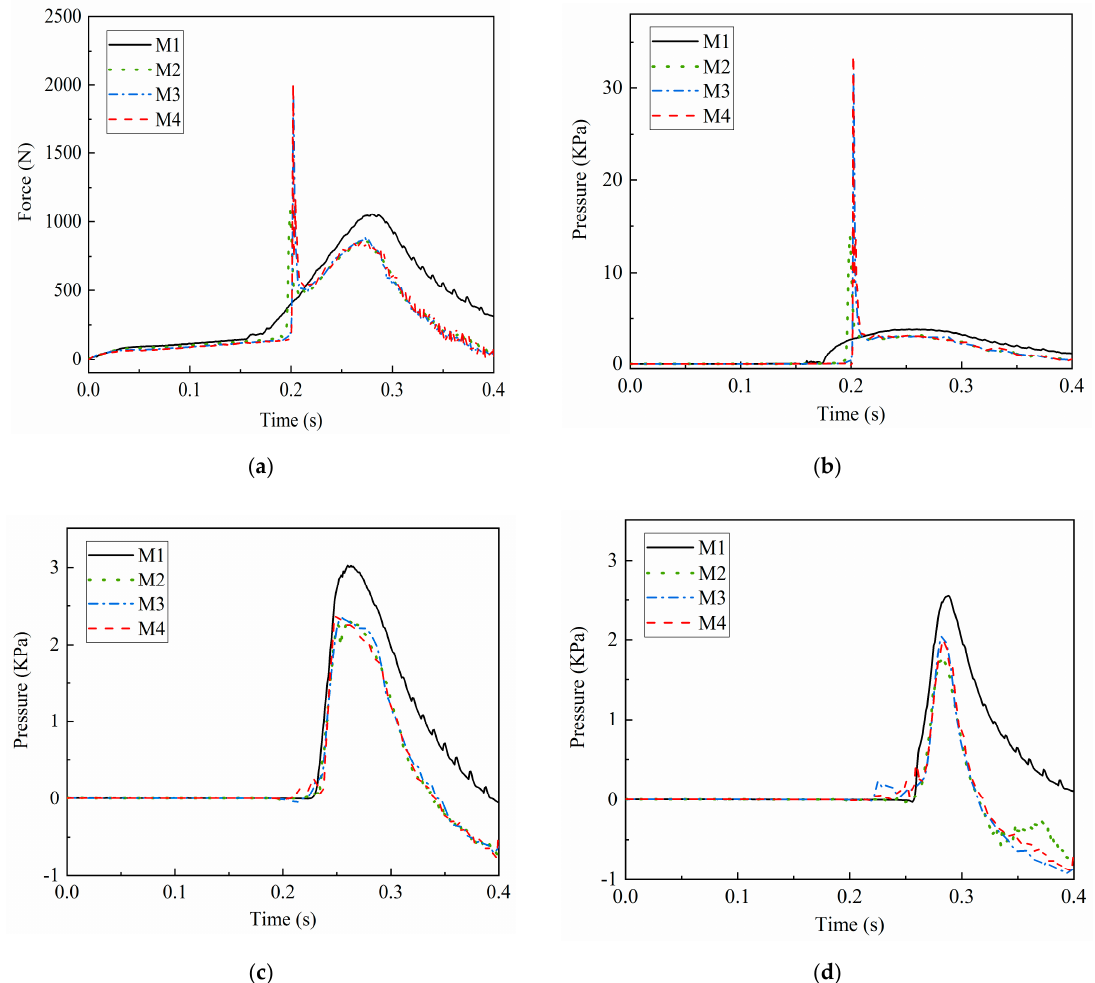
Figure 5. Impact forces and impact pressures of “S1” with different mesh densities: ( a ) impact force; ( b ) P1; ( c ) P2; ( d ) P3.